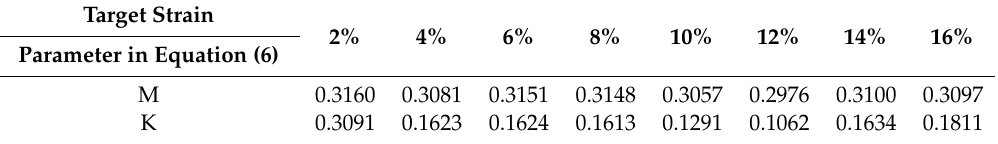
Table 2. Parameters in Equation (6) for the n value at di ff erent target